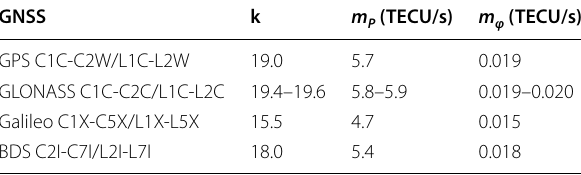
Table 5 Theoretical accuracy of TECR for